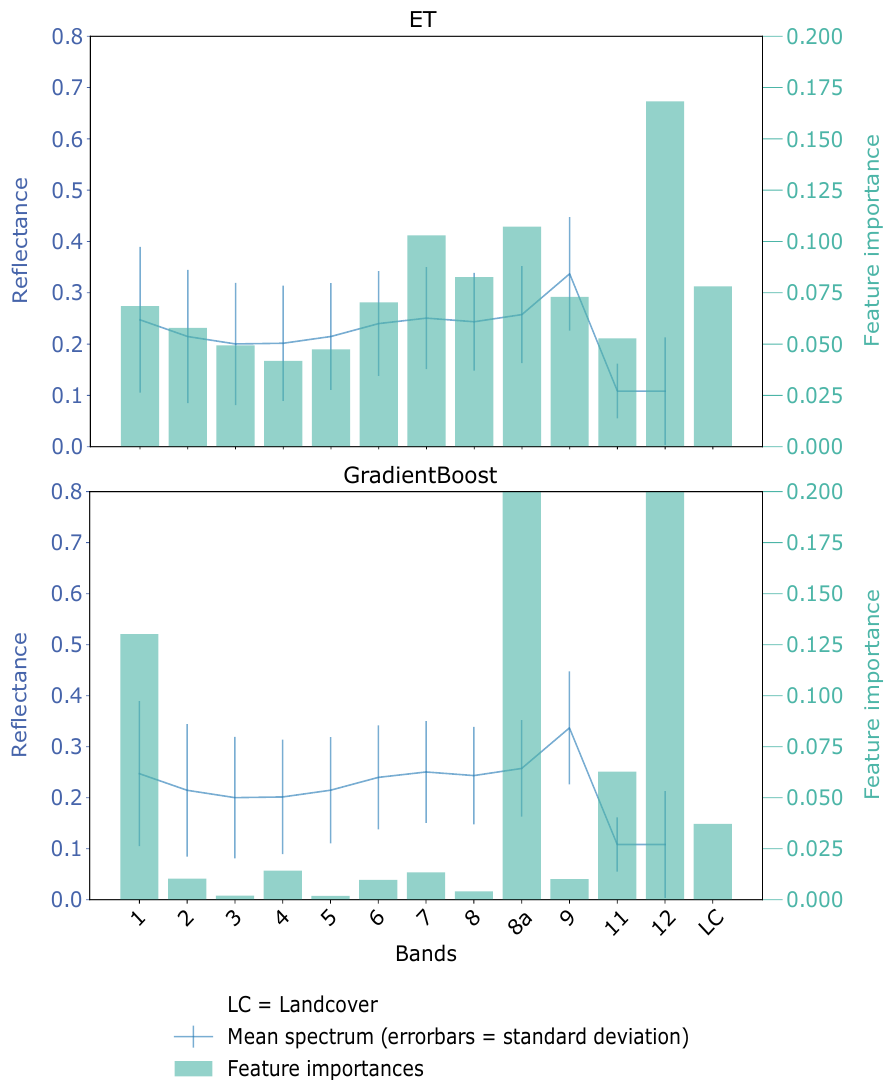
Figure 13. Exemplary feature importance for extremely randomized tree (ET) ( top ) and gradient boosting (GradientBoost) ( bottom